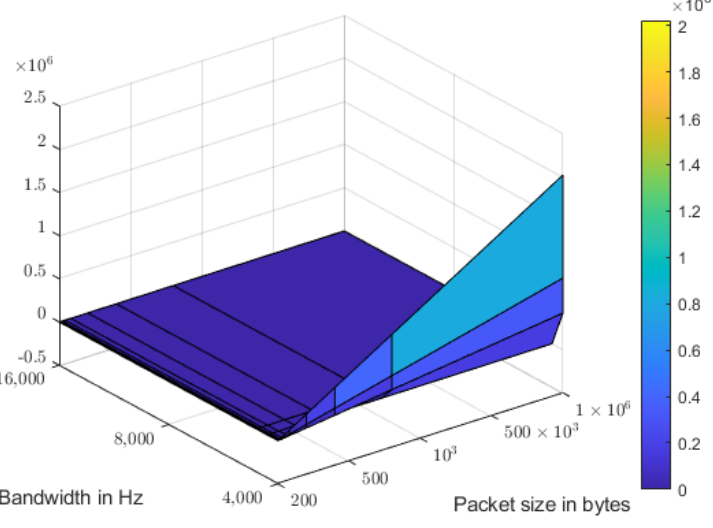
Figure 5. Threshold difference between offloading and local for end